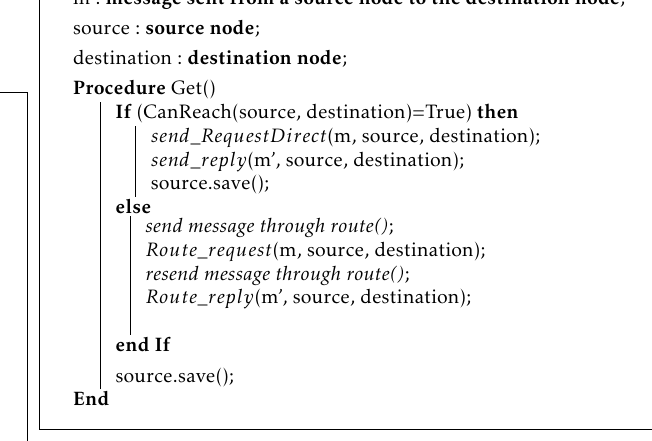
Algorithm 6: Getting data in GRAPP&S